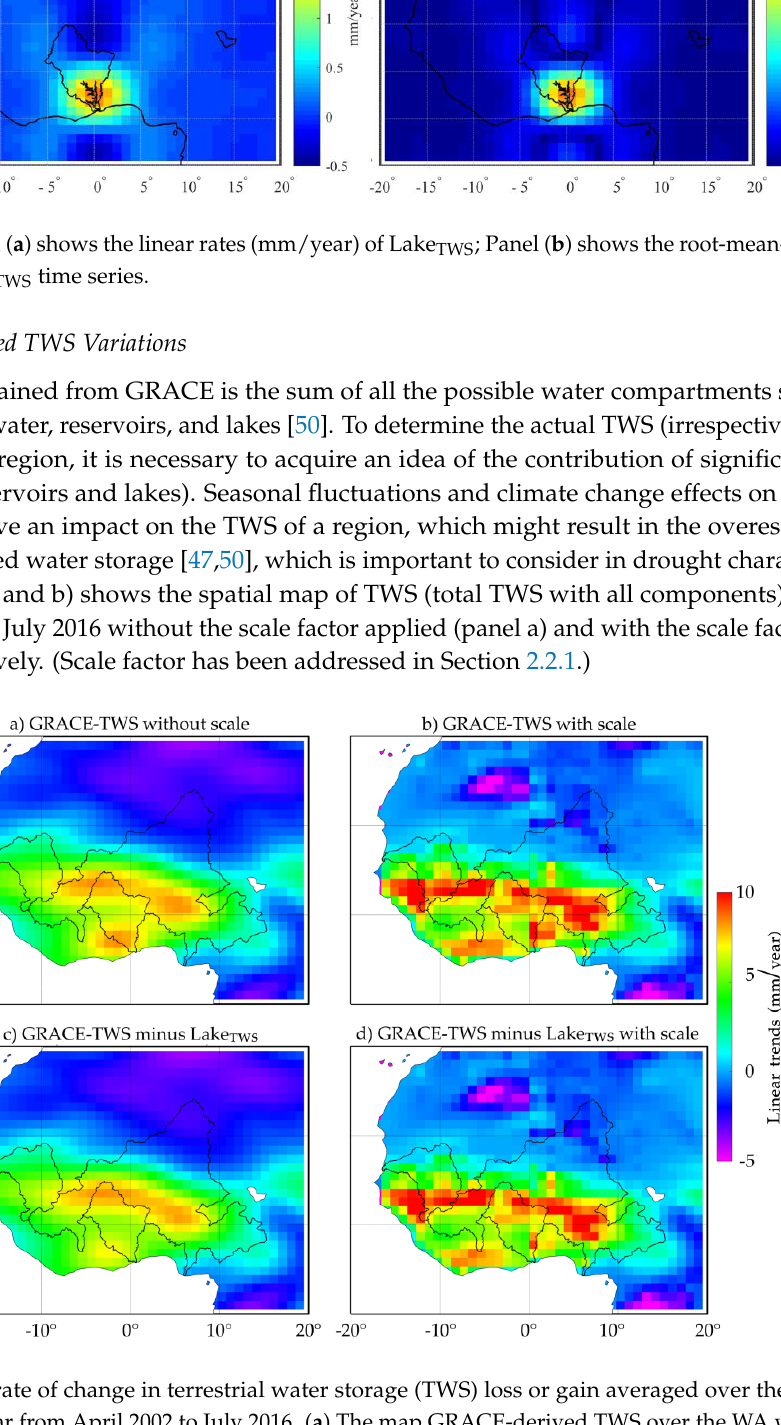
applying the scale factor; ( b ) The result of GRACE-derived TWS after applying the scale factor; ( c ) The rate of TWS after the lake effect (Figure 5a) is taken out from GRACE-TWS. ( d ) The same as panel